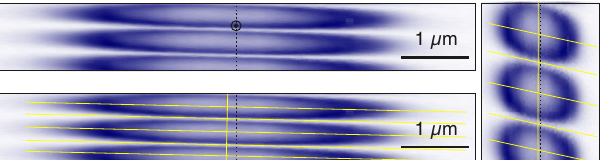
FIG. 7. Aspect ratio of the scanning images. Representations of the Fig. 2(d) scatter channel are shown with their true aspect ratio on the left. In the lower-left plot, a tilted perpendicular grid has been added. The tilt angle is − 1 . 7 °. The black circle represents the dimensions of a 150-nm-diameter nanowire, given for compari- son. The image axes ( XZ ) are the ones set by the XYZ piezo stage moving the nanowire. Right: the same image shown with the squeezed aspect ratio employed in Fig. 2 on the right. The deformation of the perpendicular grid is an artefact of the aspect ratio